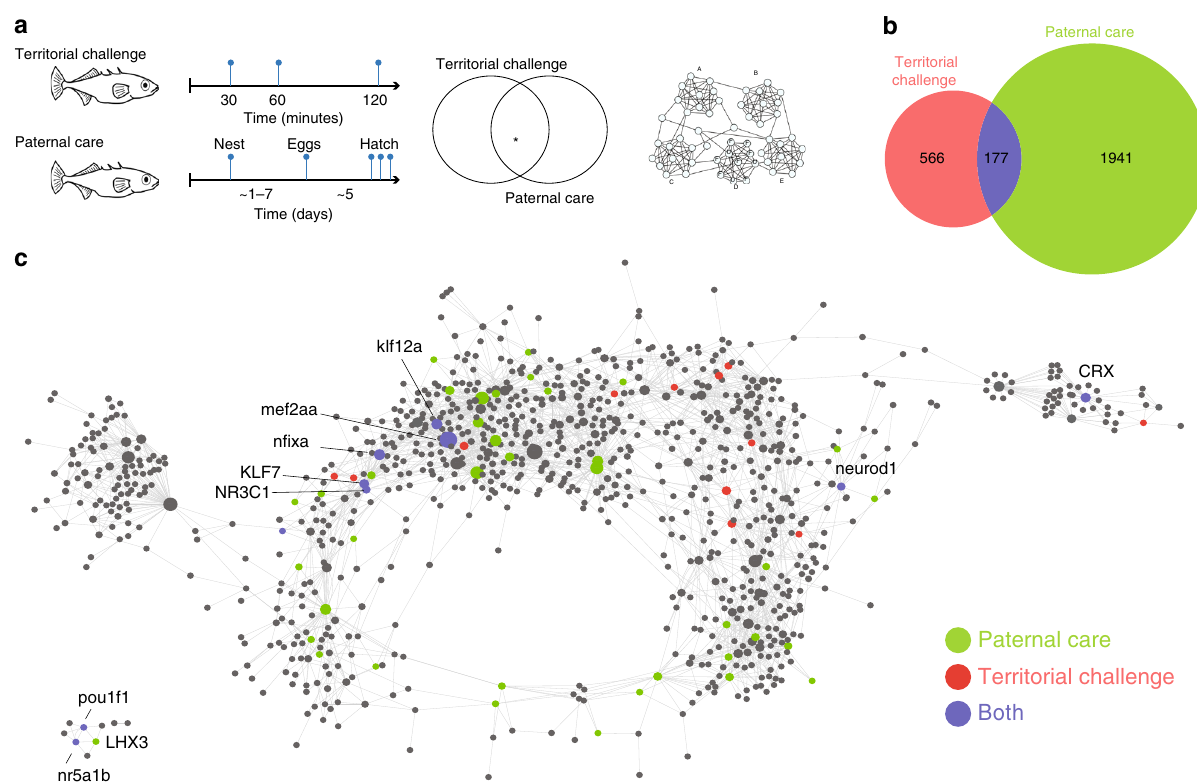
Fig. 4 The regulatory dynamics of territorial challenge and paternal care. a Experimental time course sampling design in the two experiments. b Overlap between territorial aggression and paternal care DEGs. DEGs were pooled across time points and brain regions. c ASTRIX-generated transcriptional regulatory network. Each node represents a transcription factor or a predicted transcription factor target gene. Oversized nodes are transcription factors where the size of the node is proportional to the number of targets. Transcription factors whose targets are signi fi cantly enriched in either or both experiments are highlighted with different colors. Stickleback imaged drawn by MB. Source data are in GEO